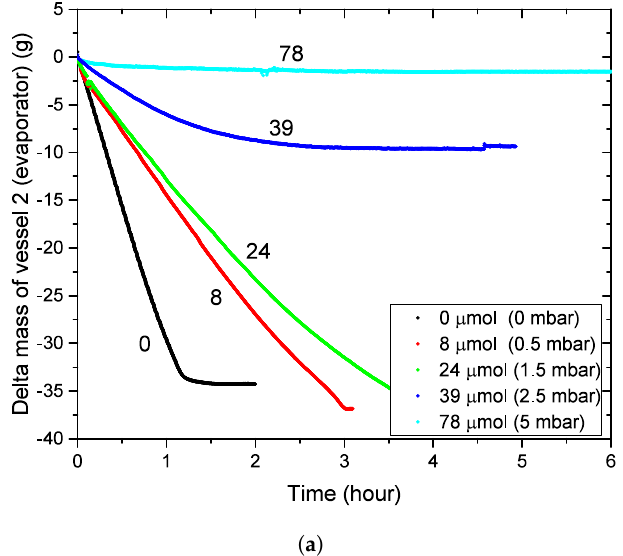
Figure 8. Mass change of vessel 2 during evaporation.